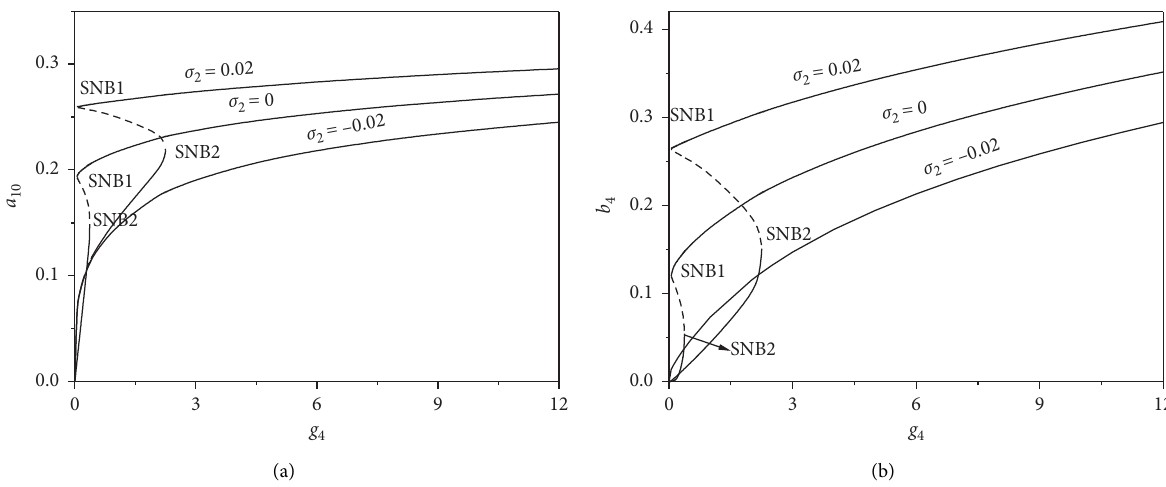
Figure 8: Variations in the force-response curves of the (a) cable and (b) arch with g and σ